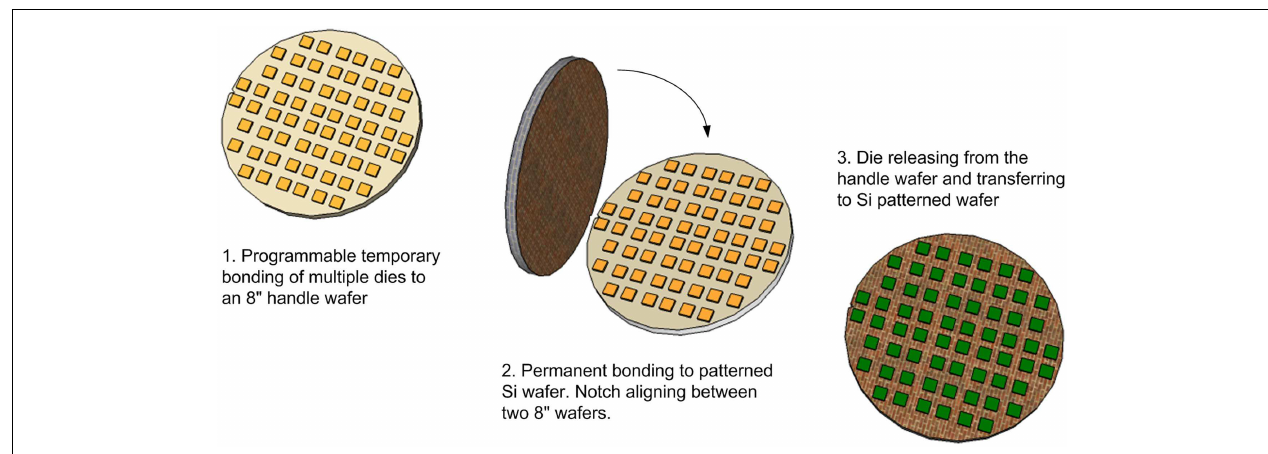
FIGURE 3 | Illustration of the key processing steps of the multiple D2W bonding technology